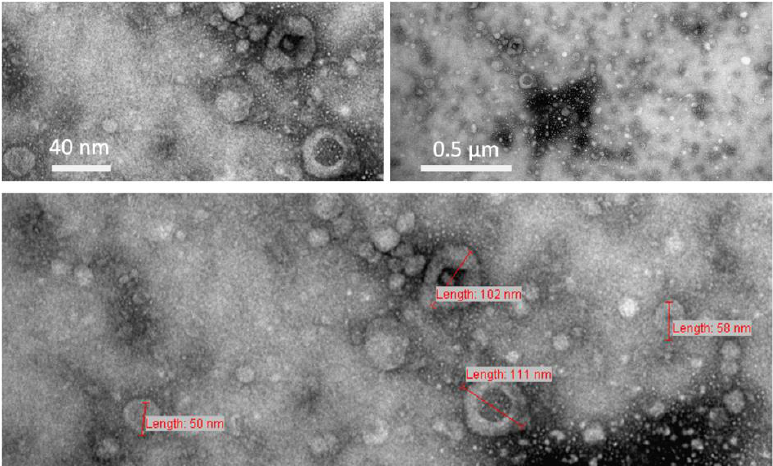
Figure 1. Transmission electron microscopy images of extracellular vesicles isolated by ultracentrif- ugation. Here, representative pictures from 786-O EVs are shown.